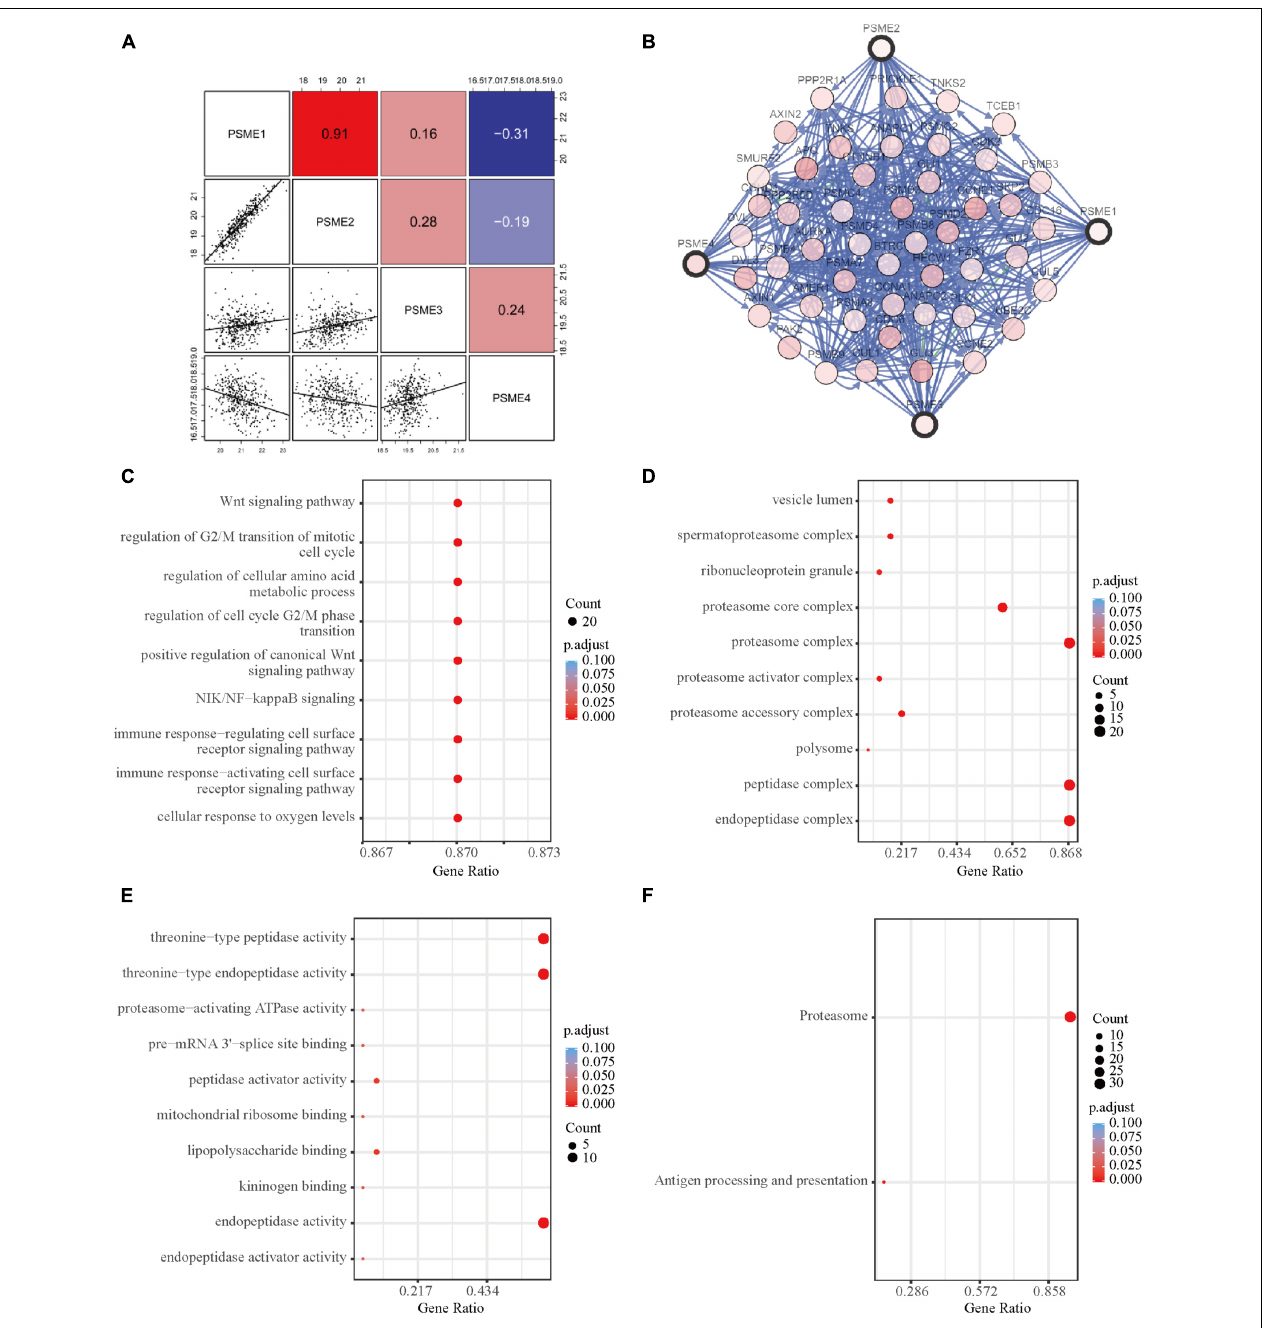
FIGURE 8 | Functional enrichment and correlation analysis of PSME genes in patients with GC. (A) Pearson correlation analysis of individual among PSME genes. (B) The network for PSME genes and the most frequently altered neighbor genes using TC3A database. (C) Biological process analysis. (D) Cellular components. (E) Molecular function. (F) Kyoto Encyclopedia of Genes and Genomes (KEGG) analysis. All of terms colored by adjusted P -value, and the size of points represent number of